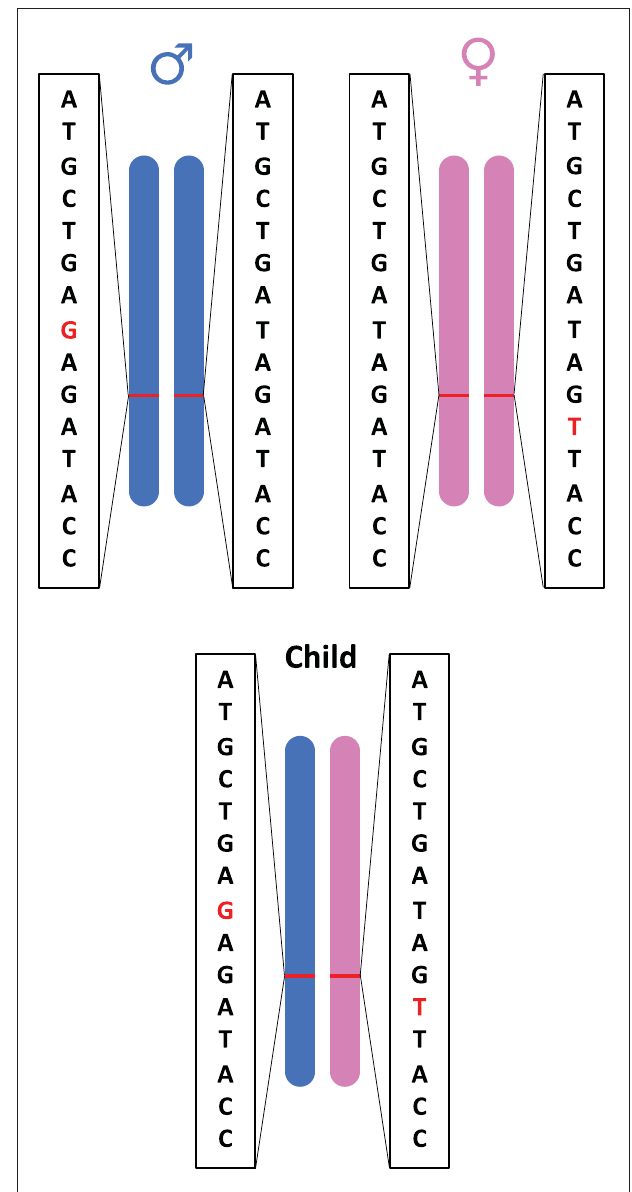
FIGURE 1 | Illustration of compound heterozygous variants. Compound heterozygous variants occur when a child has an alternate allele from each parent and the variant is located at different loci within the same